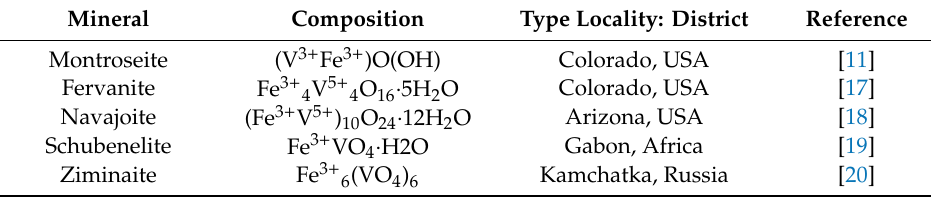
Table 4. Feric vanadium minerals with Fe:V = 1.